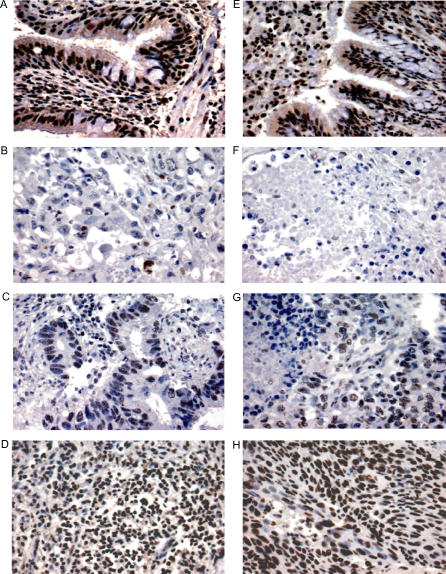

OLIG1 Immunohistochemistry on a Lung Tissue Array
OLIG1 immunohistochemistry on (A and E) tumor-free lung, (B) an OLIG1 negative adenocarcinoma, and (F) an OLIG1 negative SCC; (C) a low OLIG1 expressing adenocarcinoma and (G) a low OLIG1 expressing SCC are shown; (D) a high OLIG1 expressing adenocarcinoma and (H) a high OLIG1 expressing SCC are shown. All images were acquired at 400× magnification.